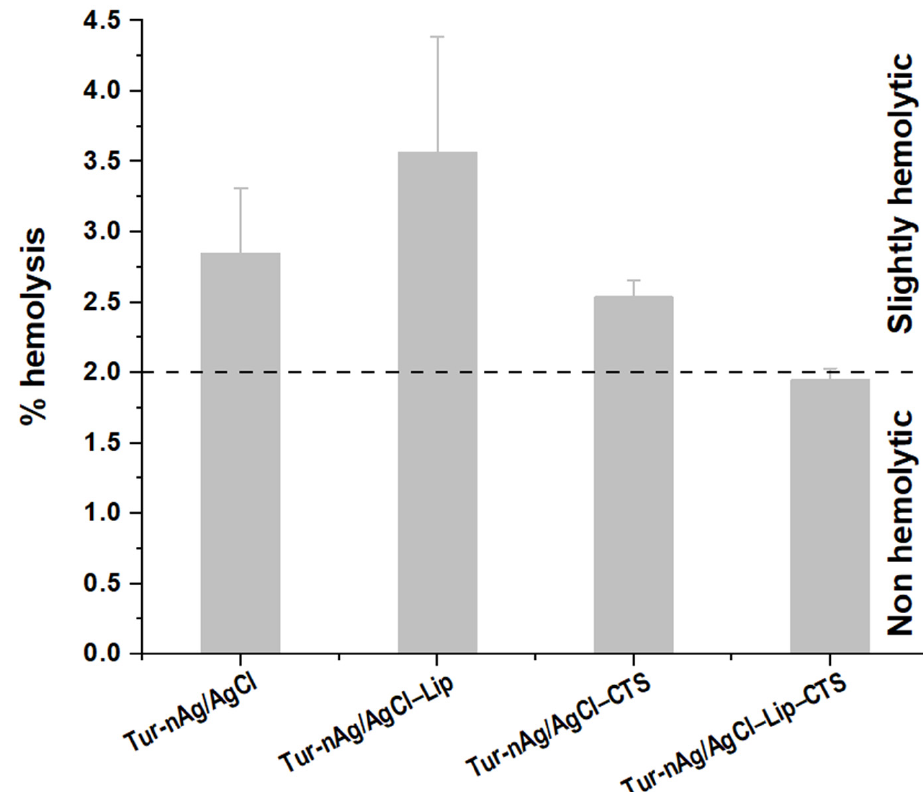
Figure 11. Percentage of hemolysis induced in hRBCs by the samples investigated.